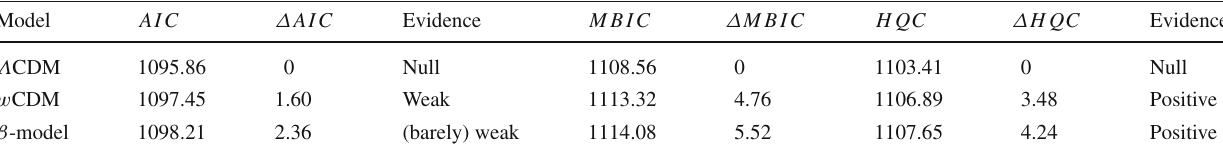
Table 3 A summary of the obtained values of AIC, MBIC and HQC for the studied models, and the Jeffreys scale with the strength evidence against a model